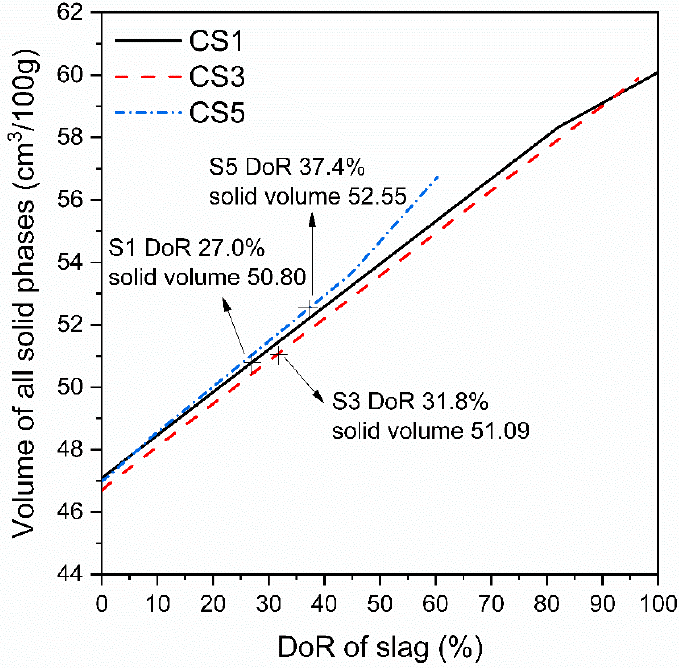
Figure 18. Relationship of solid phase volume for slag blended pastes with DoR of slag.